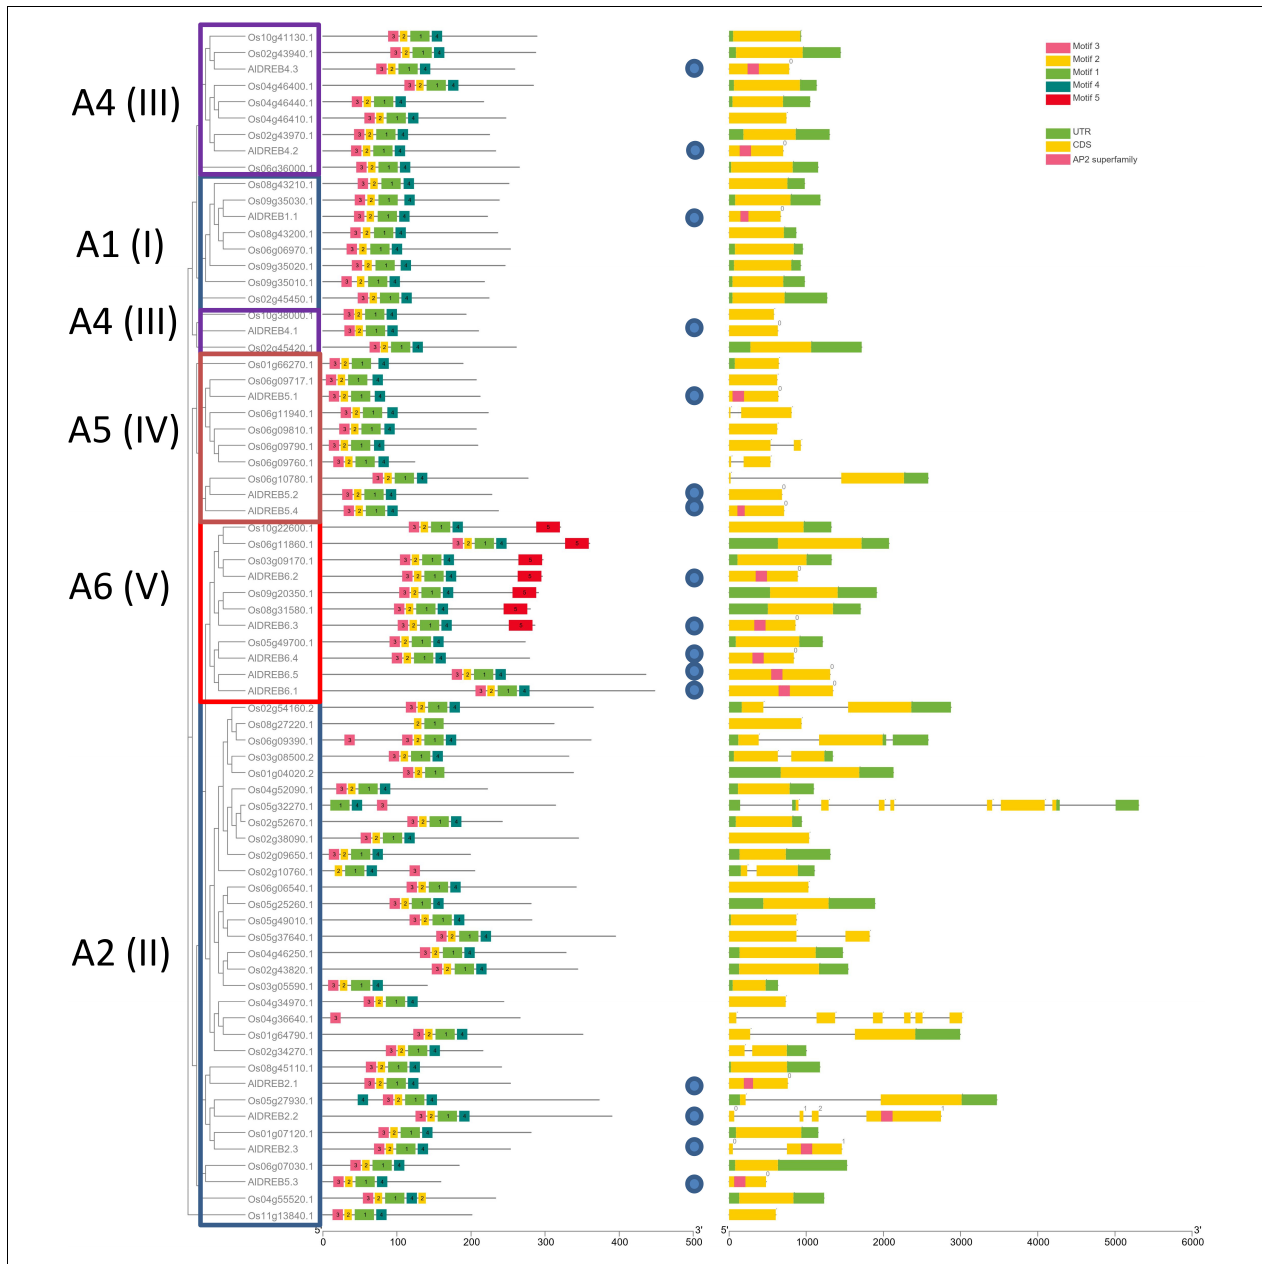
FIGURE 6 | Phylogenetic structure of Aeluropus littoralis DREB-proteins. Phylogenetic comparison of Aeluropus littoralis DREB-proteins (blue circles) with Oryza sativa DREB-proteins. Individual subfamilies (Sakuma et al., 2002) A1-A6 (I-V) are outlined by boxes and specific sequence motifs are given in the legends. (The respective AA sequence of the motifs can be found in Supplementary Table 4 ). On the right side the schematic information is given of the related genic